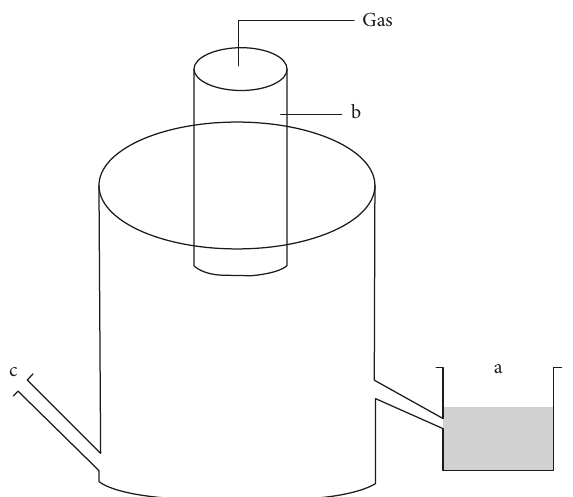
Figure 2: An illustration of our adopted token